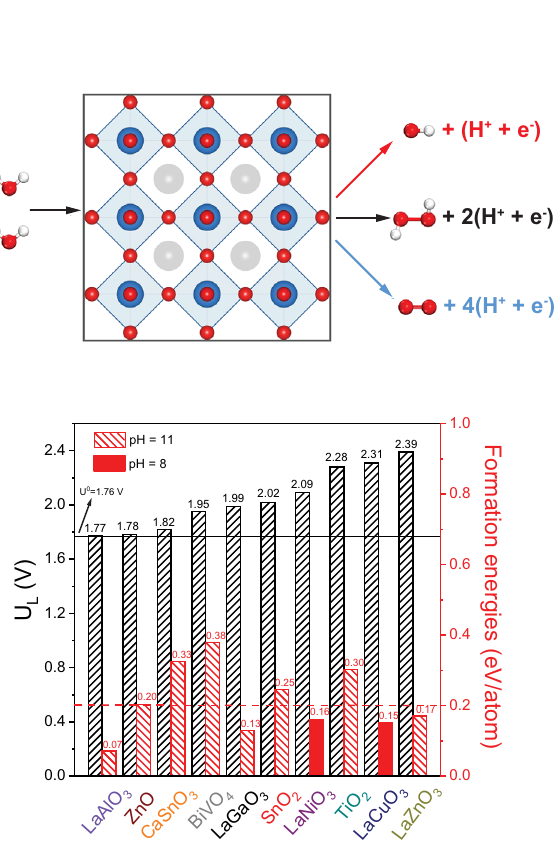
LaAlO 3 . c Calculated limiting potentials (U L , left axis) for the metal oxides, and the correspondingformationenergies(rightaxis)under2e-WOR(electrolytepH=11or 8). d Volcano plots of limiting potential as a function of Δ G OH*